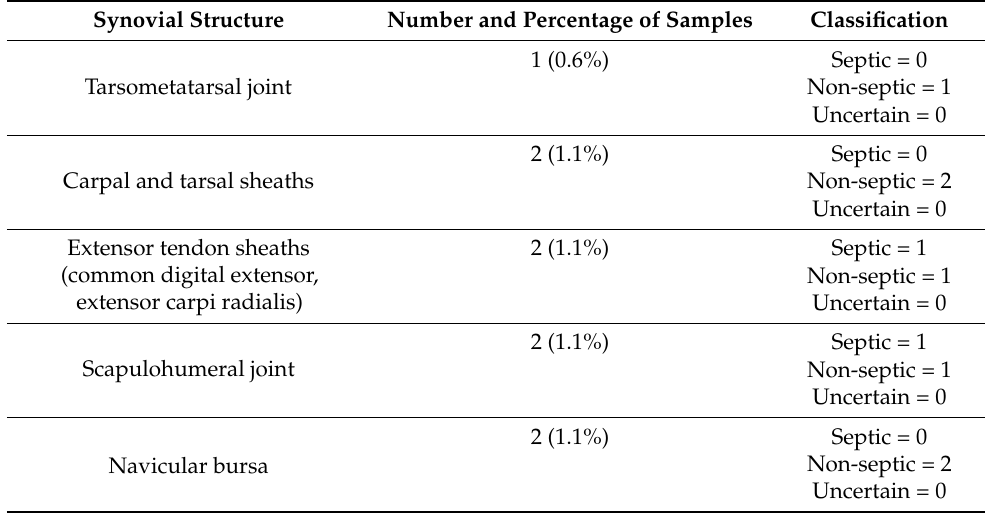
Table 1. Synovial samples ( n = 177) obtained at admission from 152 horses suspected of septic synovitis. Samples were classified as septic, non-septic, or uncertain based on total leukocyte count, differential leukocyte counts, total protein concentration, and the results of